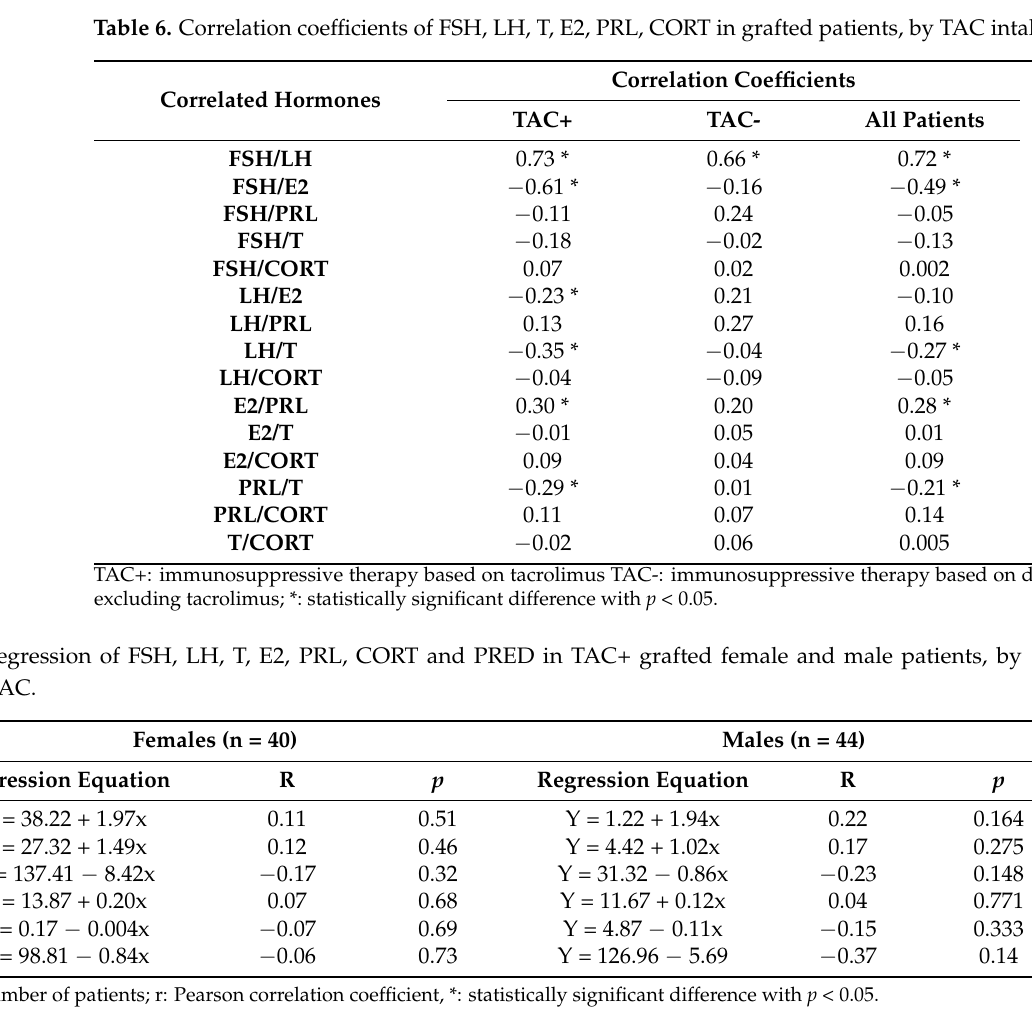
Table 8. The kidney parameters creatinine and GFR in patients by concentration of